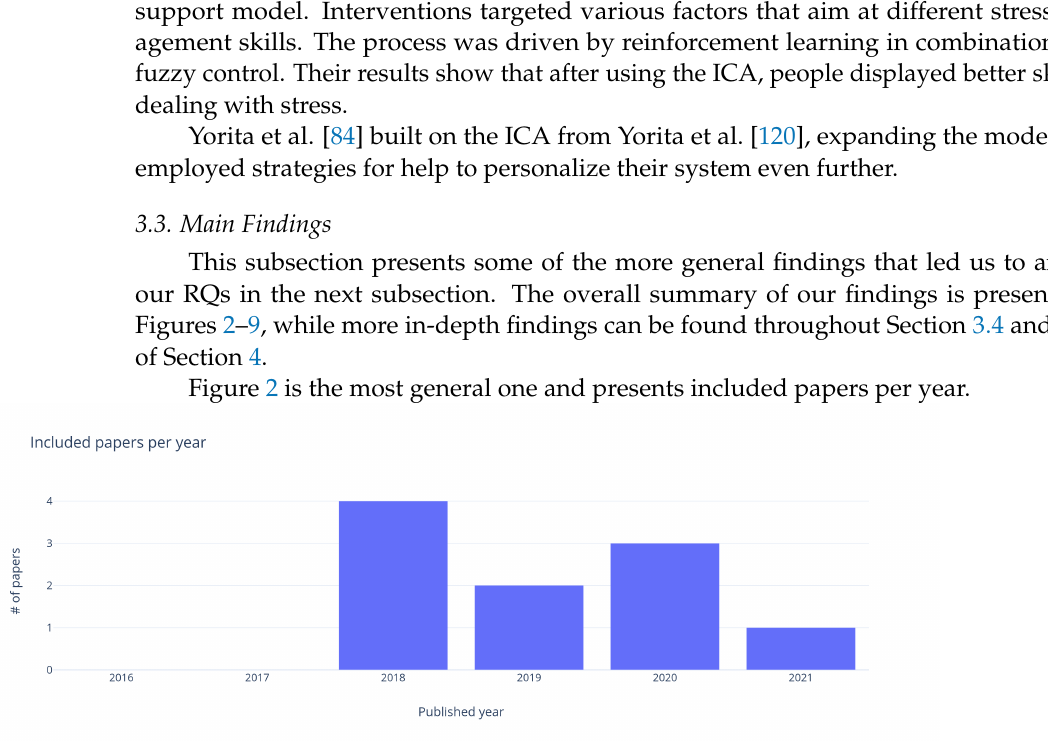
Figure 2. Included papers per year. No eligible works were found in 2016 and